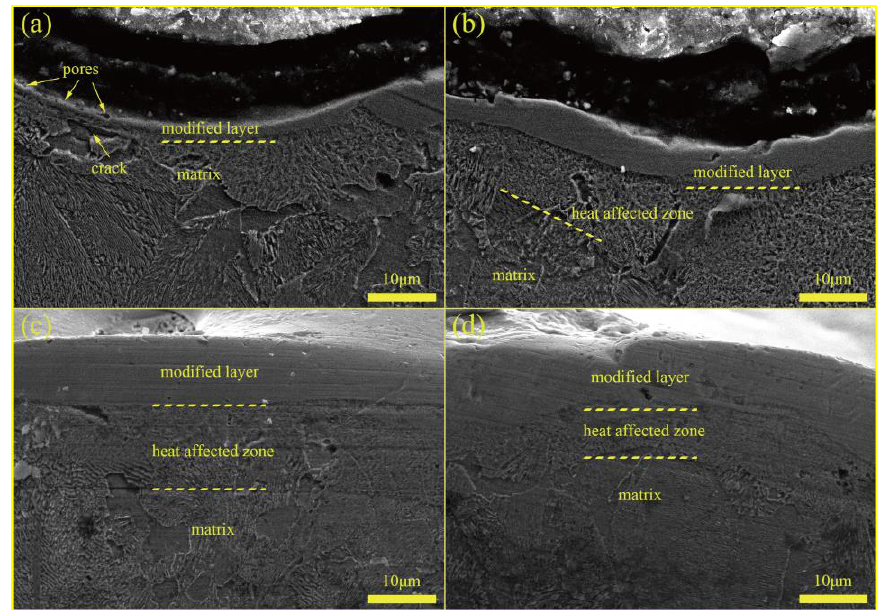
Figure 2. Cross-sectional SEM image of modified layer fabricated in same processing parameter as ( a ) non powder-mixed working dielectric, ( b ) (3A), ( c ) 6A and ( d ) 12A condition (aluminum-powder-mixed dielectric, same pulse-on time).